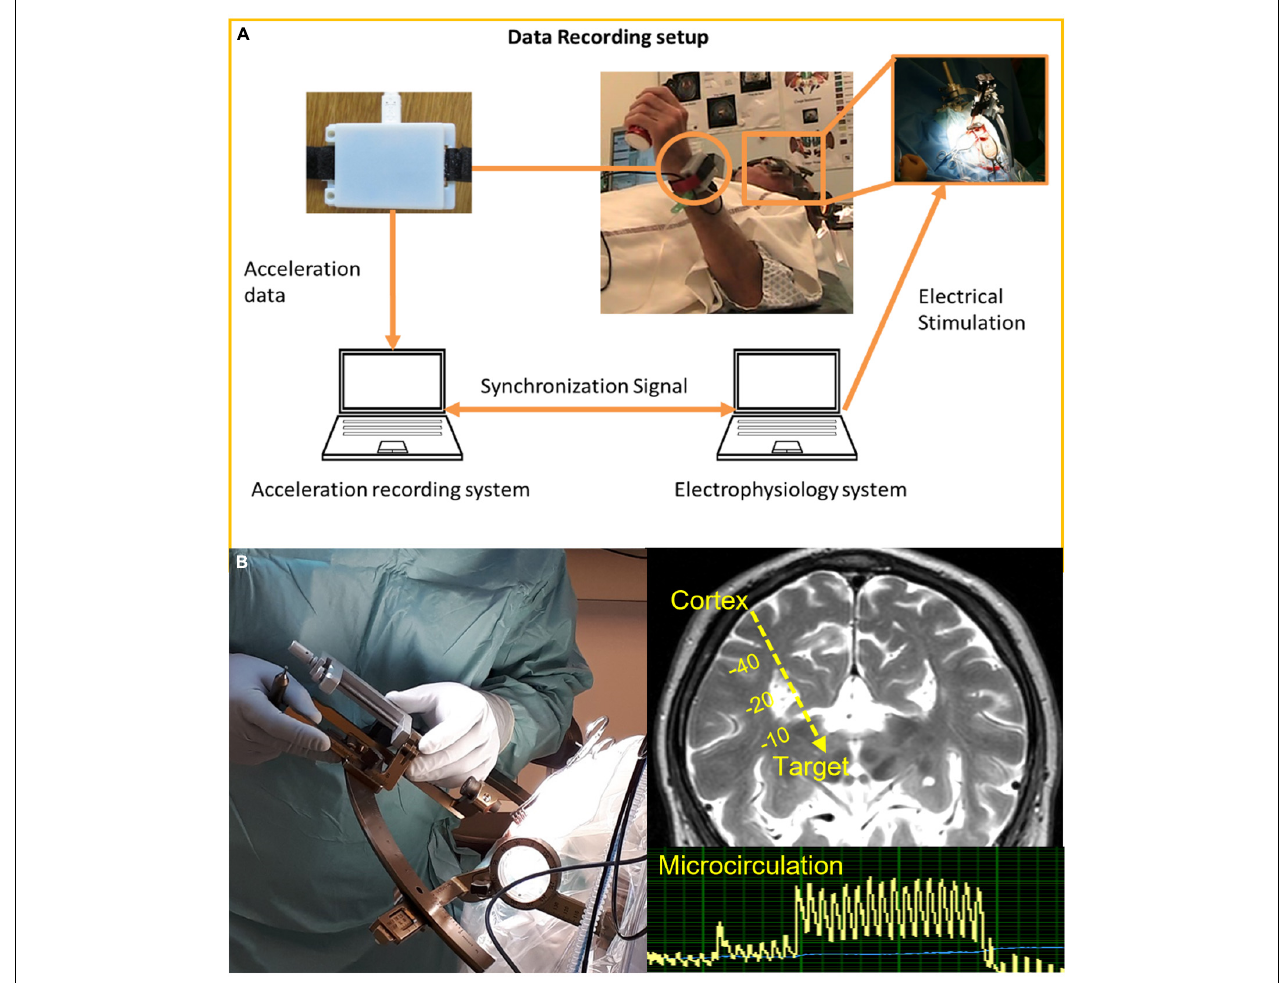
FIGURE 5 | (A) Quantitative symptom evaluation using wrist accelerometers as response to intraoperative test stimulation during DBS implantation in awake patient. Reprinted with permission from Springer Nature: Springer, Shah et al. (2017). (B) Intraoperative stereotactic laser Doppler flowmetry measurement of microcirculation along planned trajectory in relation to DBS implantation in asleep